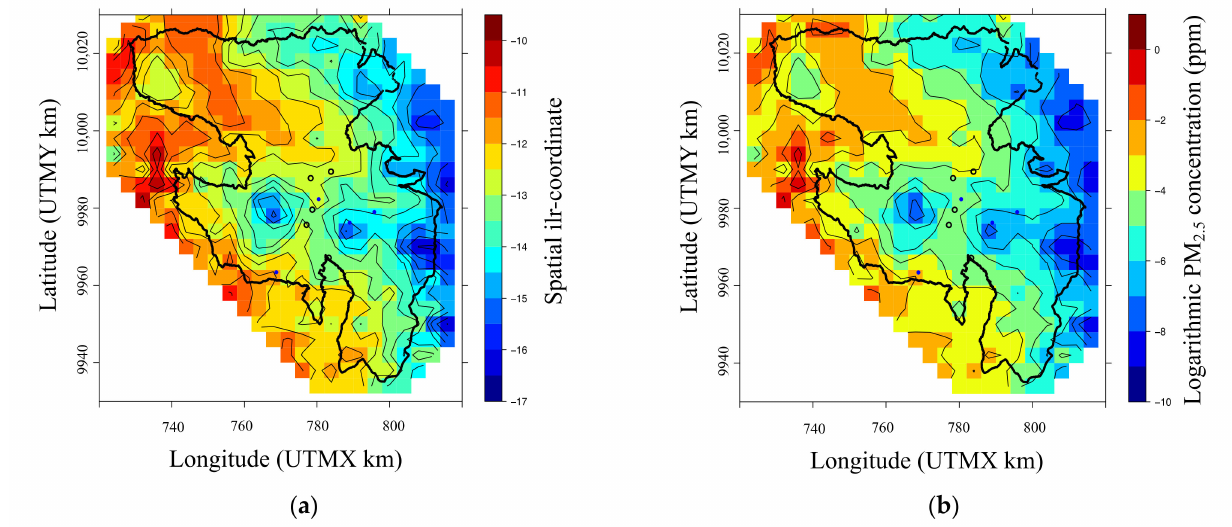
Figure 3. ( a ) The predictive ilr-coordinate related to PM 2.5 concentration on 14 September 2015; ( b ) the predictive logarithmic concentration of PM 2.5 in ppm on 14 September 2015. The black border shows the administrative boundary of